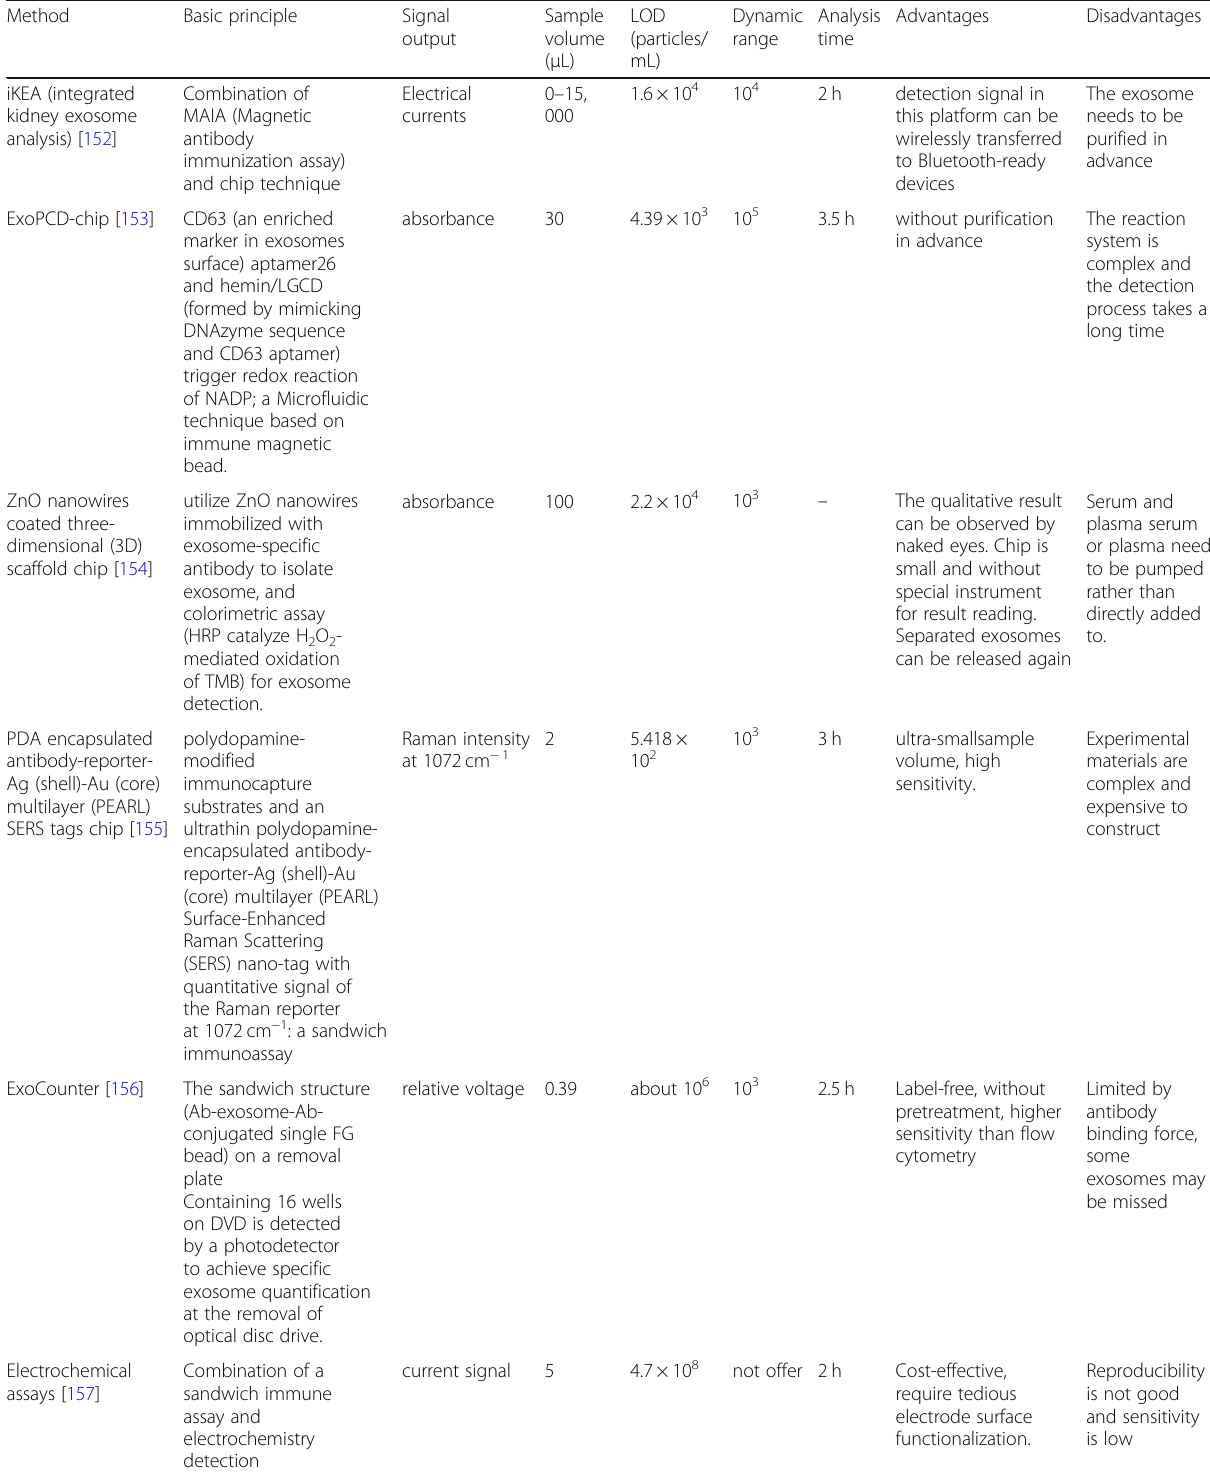
Table 5 Comparison of antibody-based analysis technology for analyzing exosome proteins